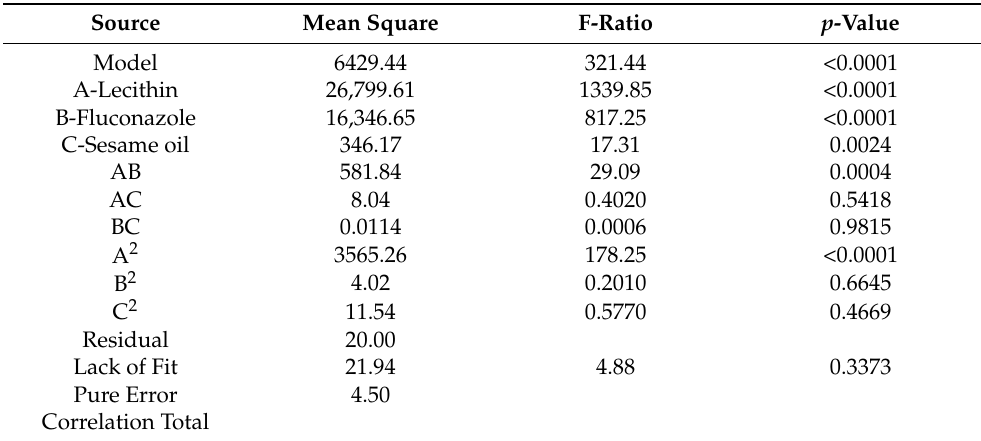
Table 3. Statistical outcome (ANOVA) of the interaction of three independent variables on globule size of